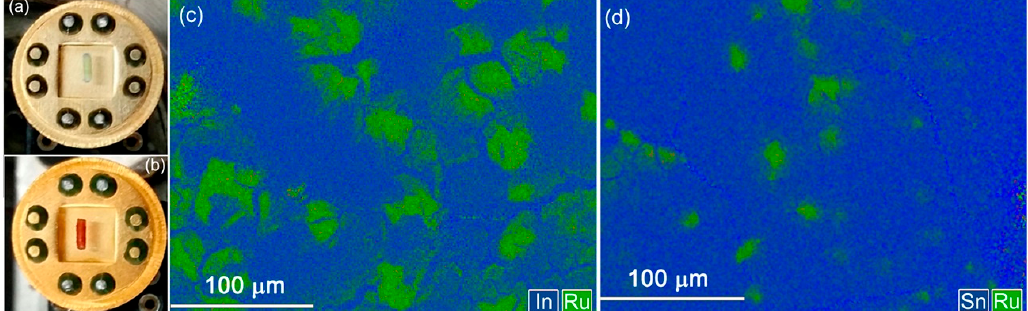
Figure 4. Optical images of SnO 2 thick films deposited on functional substrates (see Materials and Methods) before ( a ) and after ( b ) sensitization with the Ru-TT complex. EDX maps of element distribution on the surface of In 2 O 3 Ru-TT ( c ) and SnO 2 Ru-TT ( d ) thick films. Table 2. Microstructure characteristics, composition and photoresponse of investigated samples. Sample